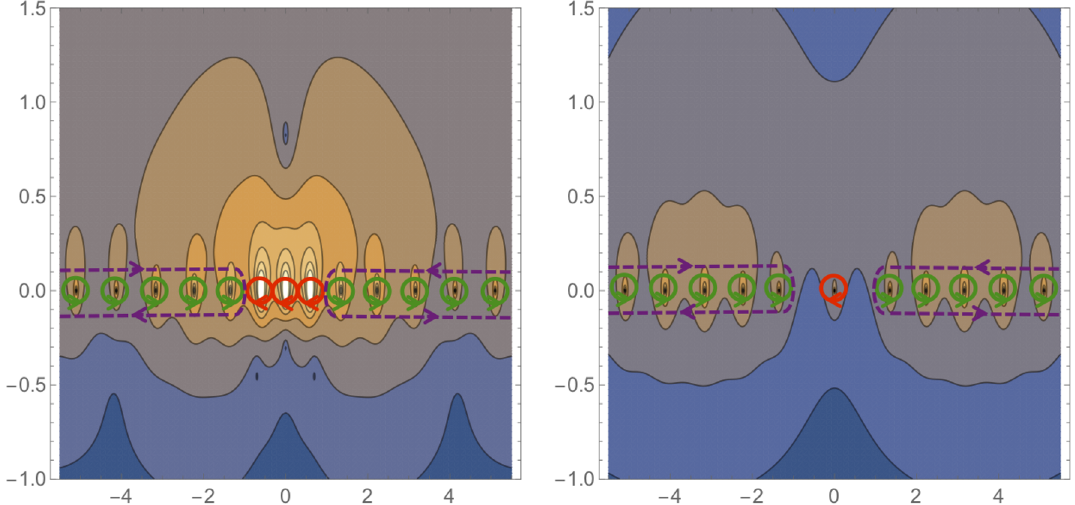
Figure 1 . Illustration of the contour manipulation for the Sommerfeld-Watson transformation. We first construct a meromorphic function that decays exponentially at infinity and that has poles at the values of m that we want to sum over. The contribution of these poles are picked up by the green contour, which we deform into the purple dashed contour, and finally into the red contour picking up the contribution of the Regge poles. On these contour plots we plot | f for v = 3 / 5 , on the left for the OTOC configuration x = x 0 = π/ 2 , y = π/ 4 , while on the right for the TOC configuration x = x 0 = π/ 4 , y = π/ 2 . These figures demonstrate that for the TOC configuration the m = ± v Regge poles disappear, that the arc contributions at infinity can be dropped and that there are no additional poles or cuts on the complex m plane that our analysis would have